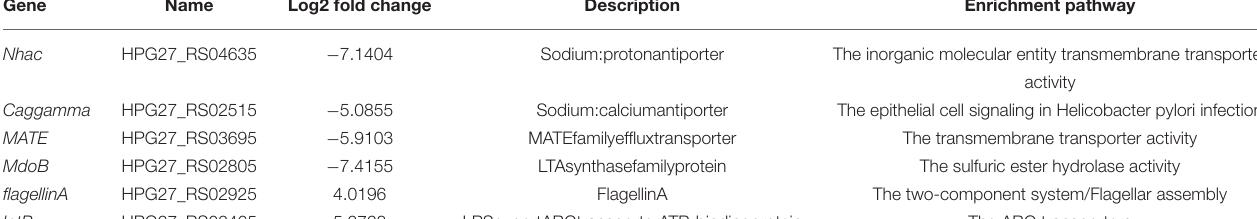
TABLE 3 | Differentially expressed genes.